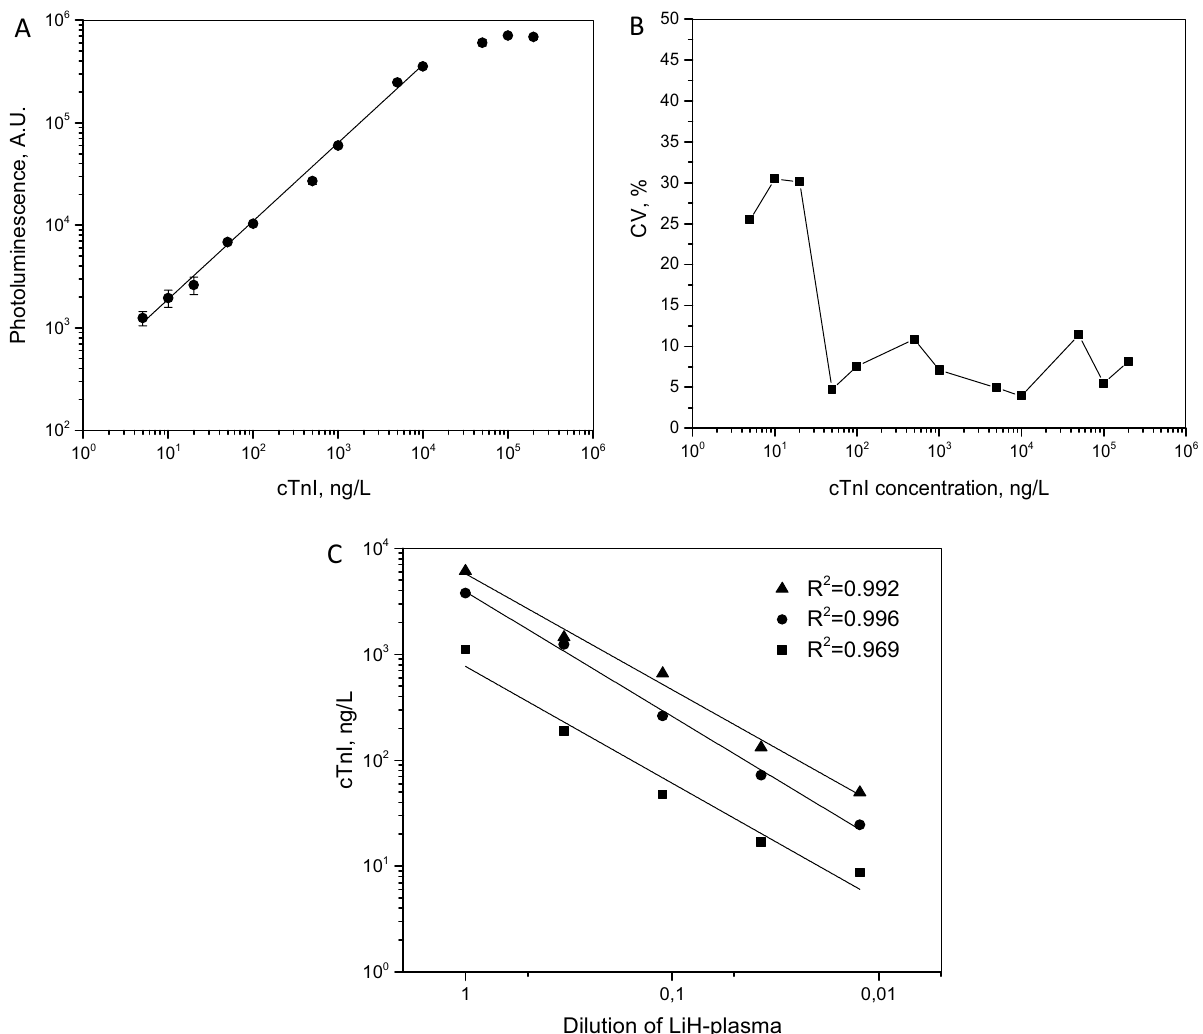
Figure 2. Analytical performance of the developed proof of concept cTnI LF test, showing the standard curve, precision profile and parallelism. ( A ) Calibration curve for the UCNP-LFIA. The error bars represent the standard deviation of three replicate strips. Equation of the curve was y = 0.76x + 2.52, R2 = 0.996. ( B ) Precision profile determined from the calibration curve measurements. CV% describes the variation between the calculated cTnI concentrations. ( C ) Parallelism of the UCNP-LFIA. Three clinical LiH-plasma samples containing variable amounts of endogenous cTnI were serially diluted to 1/81-fold with blank LiH-plasma